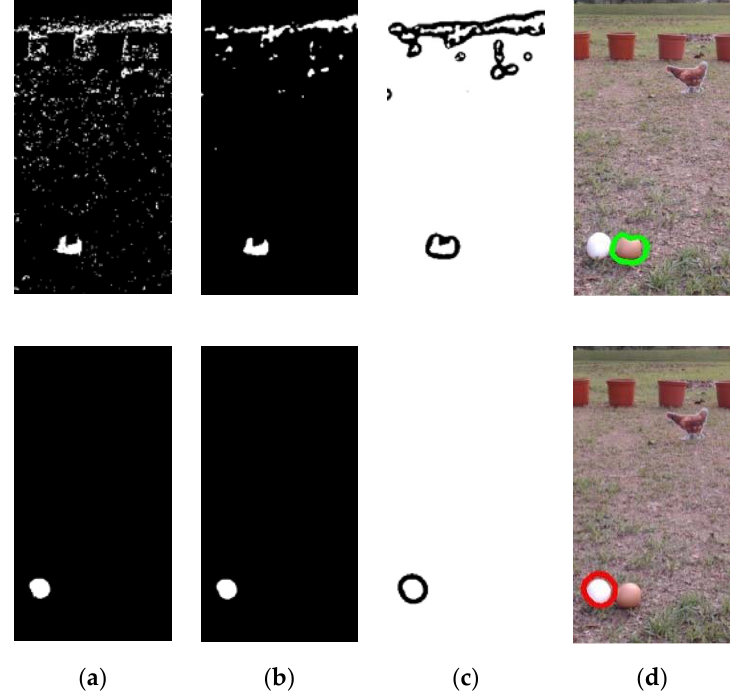
Figure 3. Egg recognition results for brown (top) and white eggs (bottom): ( a ) remove background; ( b ) median filtering; ( c ) contour finding; ( d ) polygon fitting and roundness test.